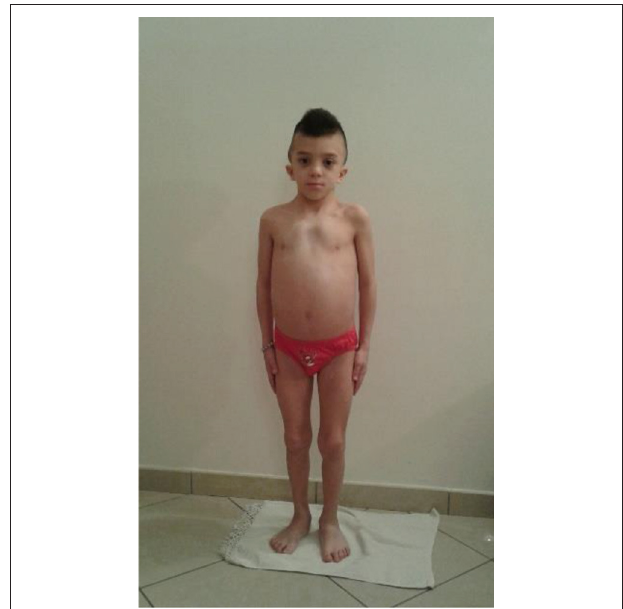
FIGURE 1 | Child with atypical case of Noonan syndrome (NS) with mesomelic short stature.